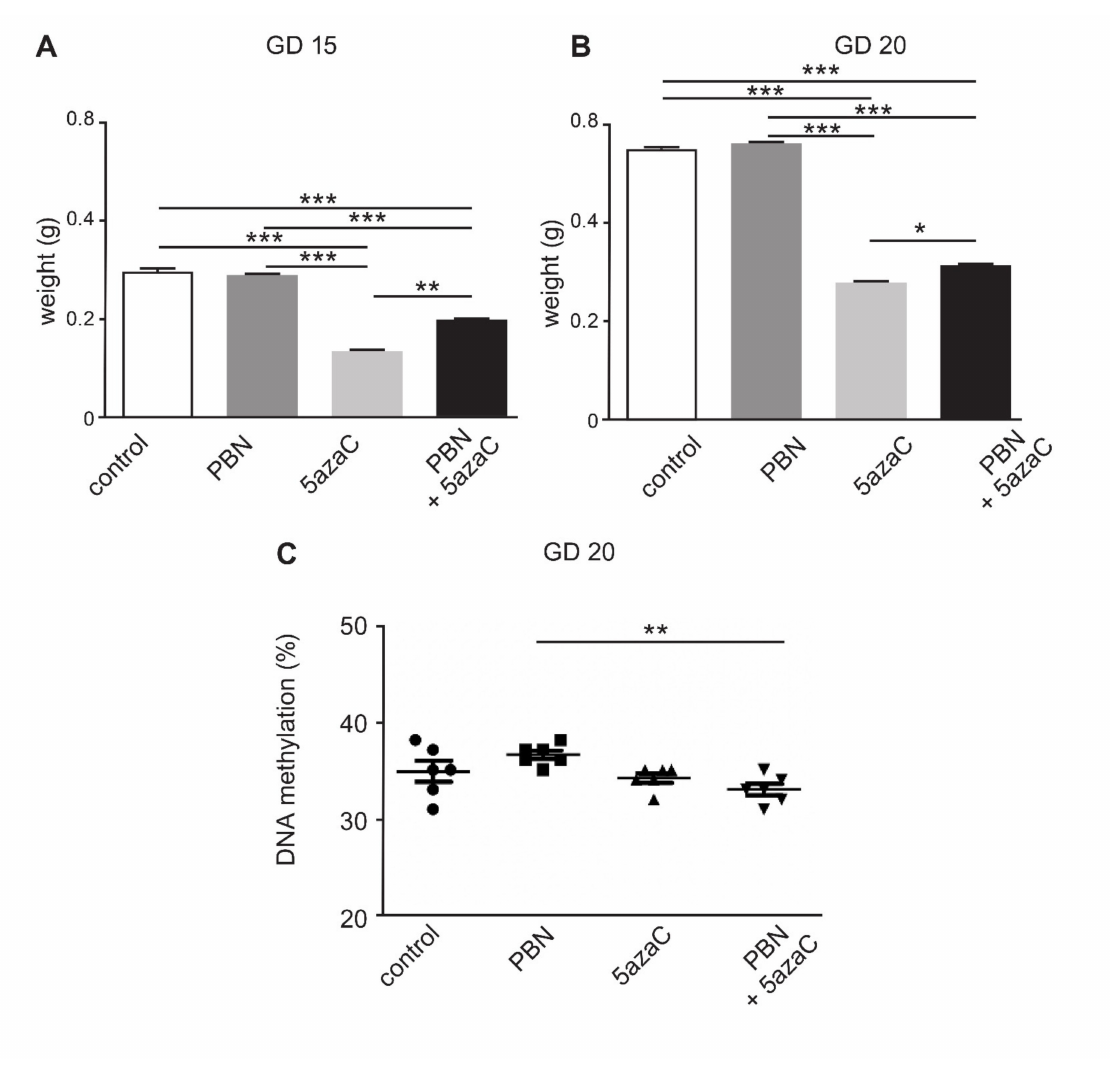
Figure 1. Weight and global DNA methylation of rat placentas from dams treated with N-tert-Butyl- α - phenylnitron (PBN) and/or 5-azacytidine (5azaC) on gestational day (GD) 12–13. Weight of placentas isolated on GD 15 ( A ) or GD 20 ( B ). Percentage of DNA methylation in 20-days old placentas of dams ( C ). ANOVA ( A , B ) or Kruskall Wallis test ( C ), * p < 0.05, ** p < 0.001, *** p <